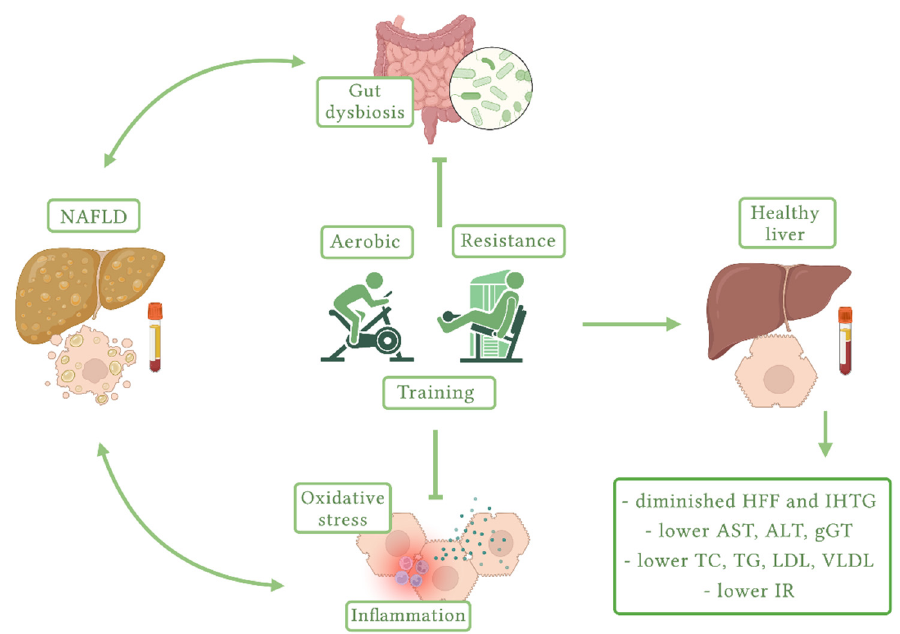
Figure 3. Benefits of exercise on NAFLD (created with BioRender.com, accessed on 1 July 2022). NAFLD, non-alcoholic fatty liver disease; HFF, hepatic fat fraction; IHTG, intrahepatic triglycerides; AST, aspartate aminotransferase; ALT, alanine aminotransferase; gGT, gamma-glutamyl transferase; TC, total cholesterol; TG, triglycerides; LDL, low-density lipoprotein; VLDL, very-low-density lipoprotein; IR, insulin resistance.